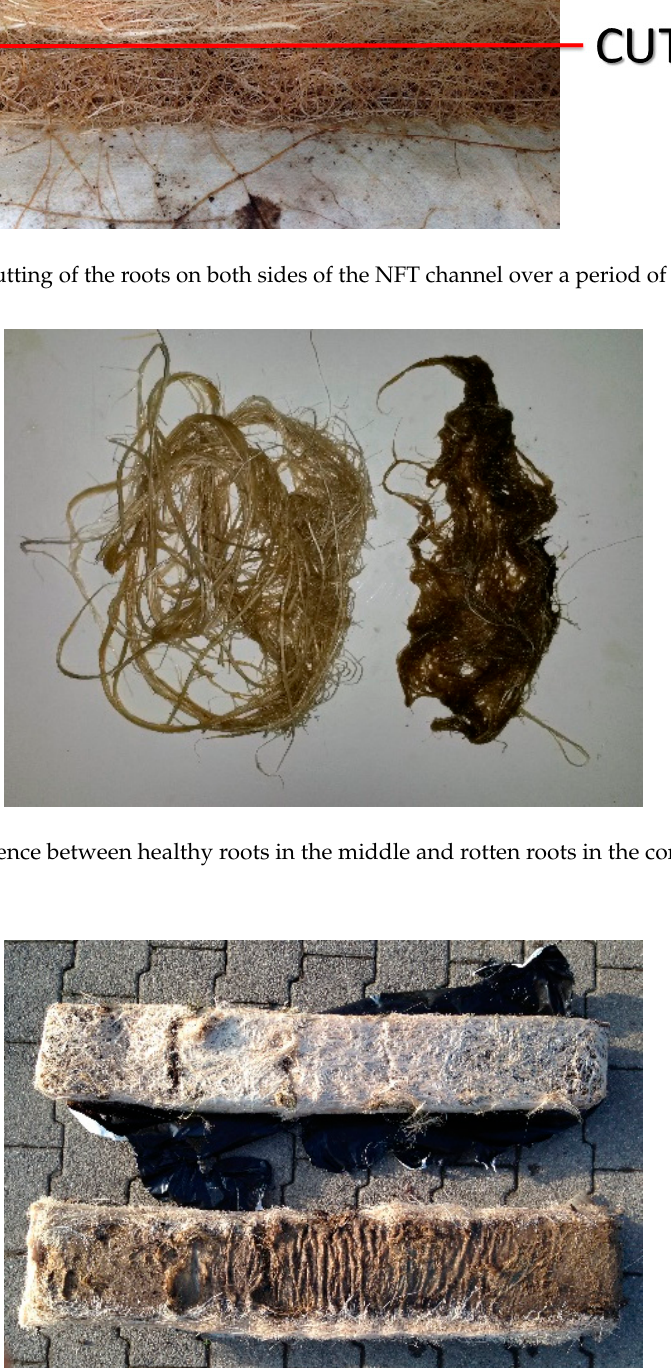
Figure A5. Rotten roots on the bottom of the NFT channels ( bottom ); and healthy roots in drip irrigation ( top ).